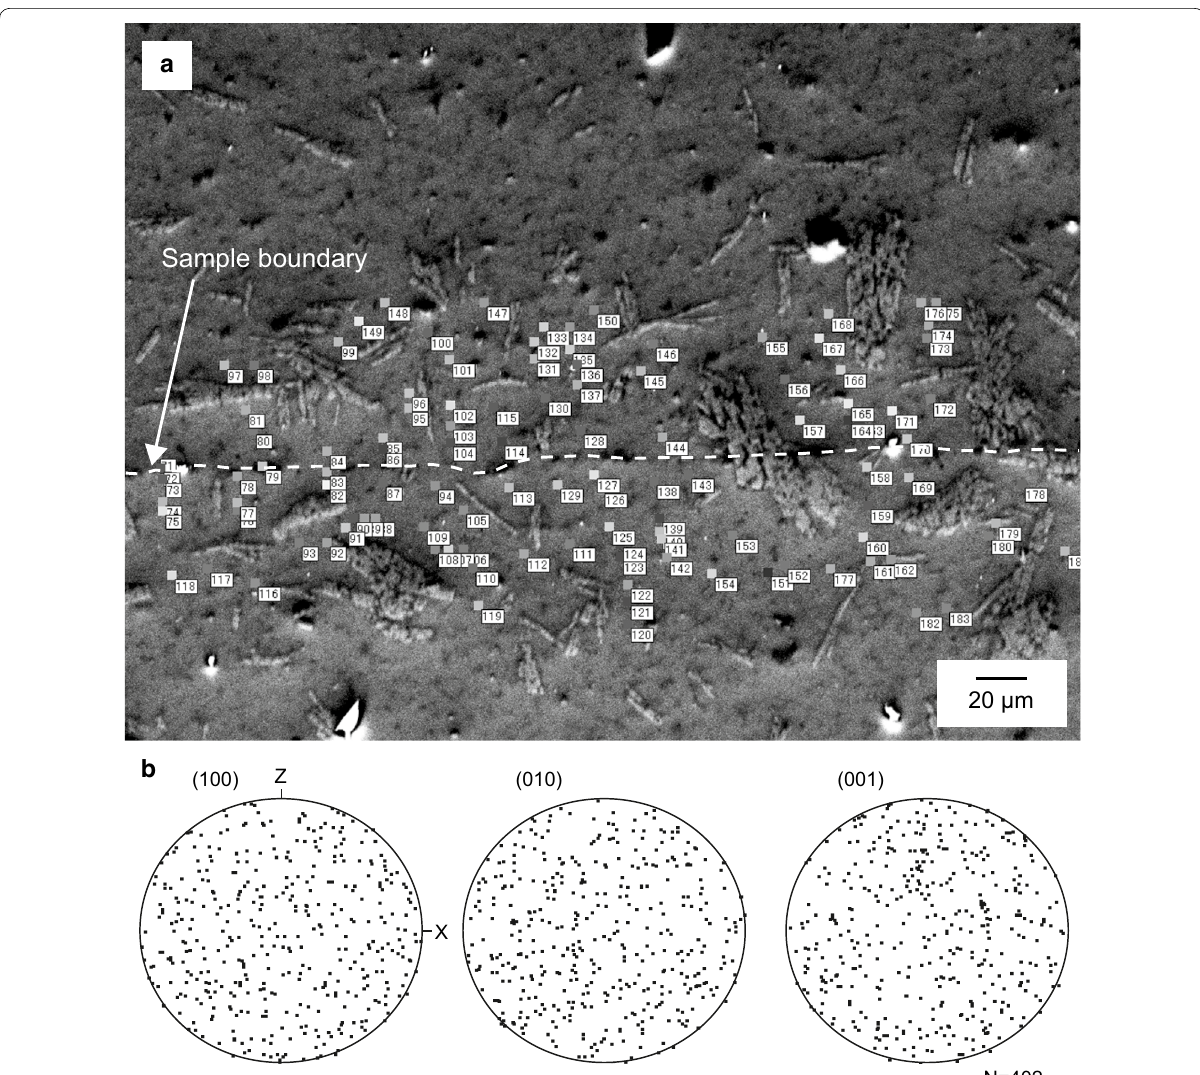
Fig. 8 EBSD measurement results for anorthite grains in the water‑added sample. a Example of point analysis in a BSE image. The measurements were taken within 50 μm of the upper and lower sample boundaries (white dashed lines). b Pole figures for the representative crystallographic planes at an equal‑area and lower hemisphere projection. Elongation (i.e., bulging) and shortening directions are denoted as X and Z ,